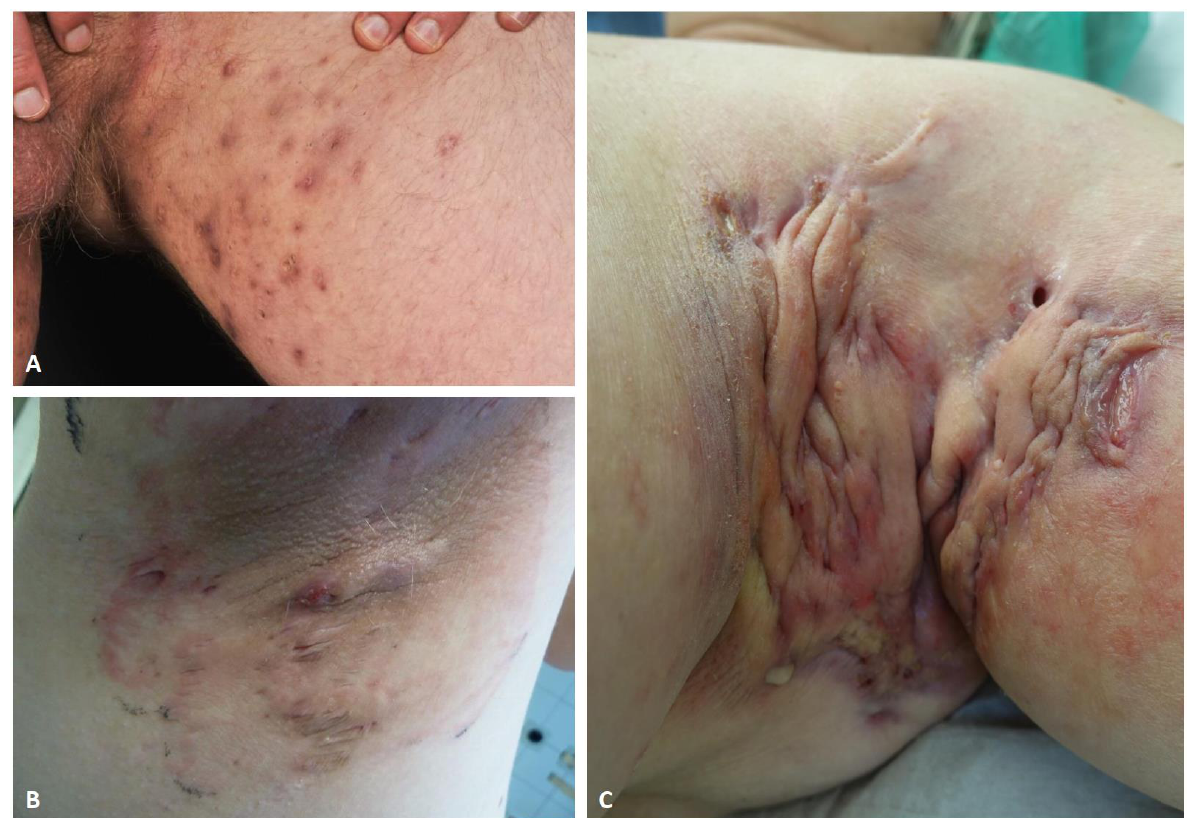
Figure 1. Clinical images of typical HS lesions in groin ( A ), and axilla ( B , C ). Superficial papules, small abscesses without scarring or sinus tracts, Hurley stage I ( A ). Multiple, recurrent abscesses with initial sinus tracts and cicatrization, Hurley stage II ( B ). Diffuse involvement of the axillary region with large abscesses, interconnected tracts, and scarring, Hurley stage III ( C ).